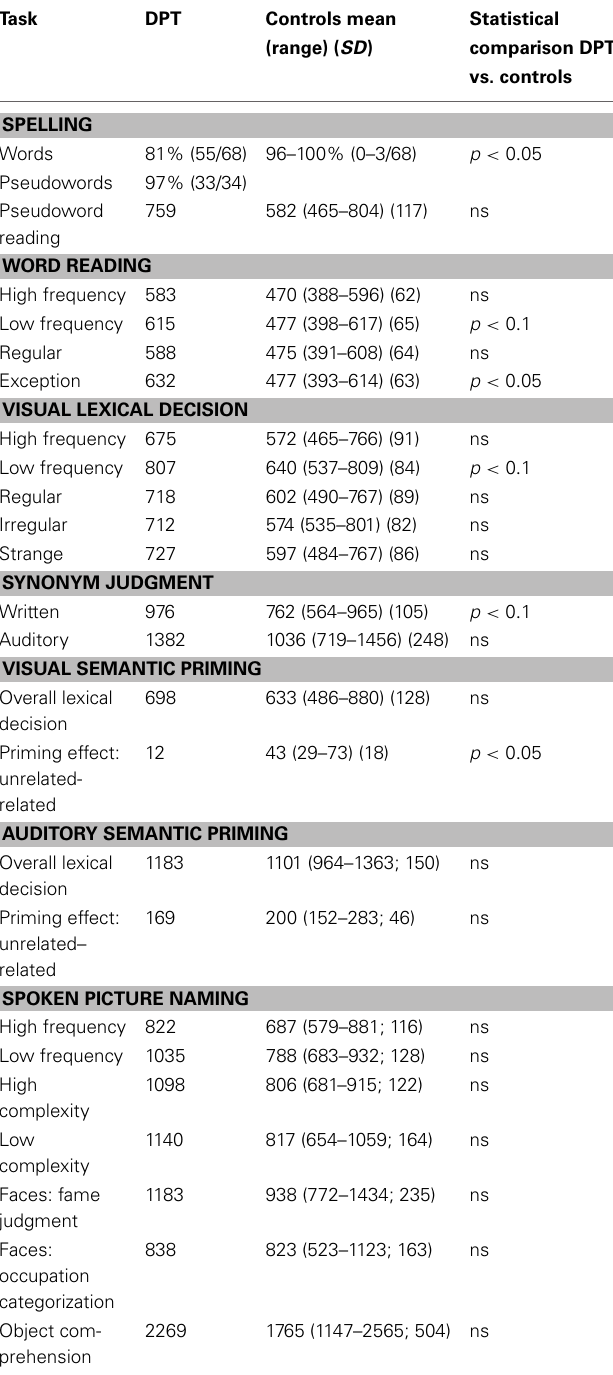
Table 1 | Summary of behavioral testing reported in Tsapkini and Rapp (2010) and Tsapkini et al.